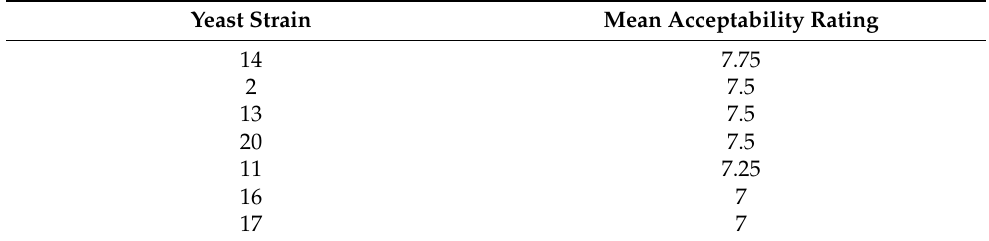
Table 4. Average mean acceptability ratings of new make spirit samples that achieved a mean rating of 7 or above (out of